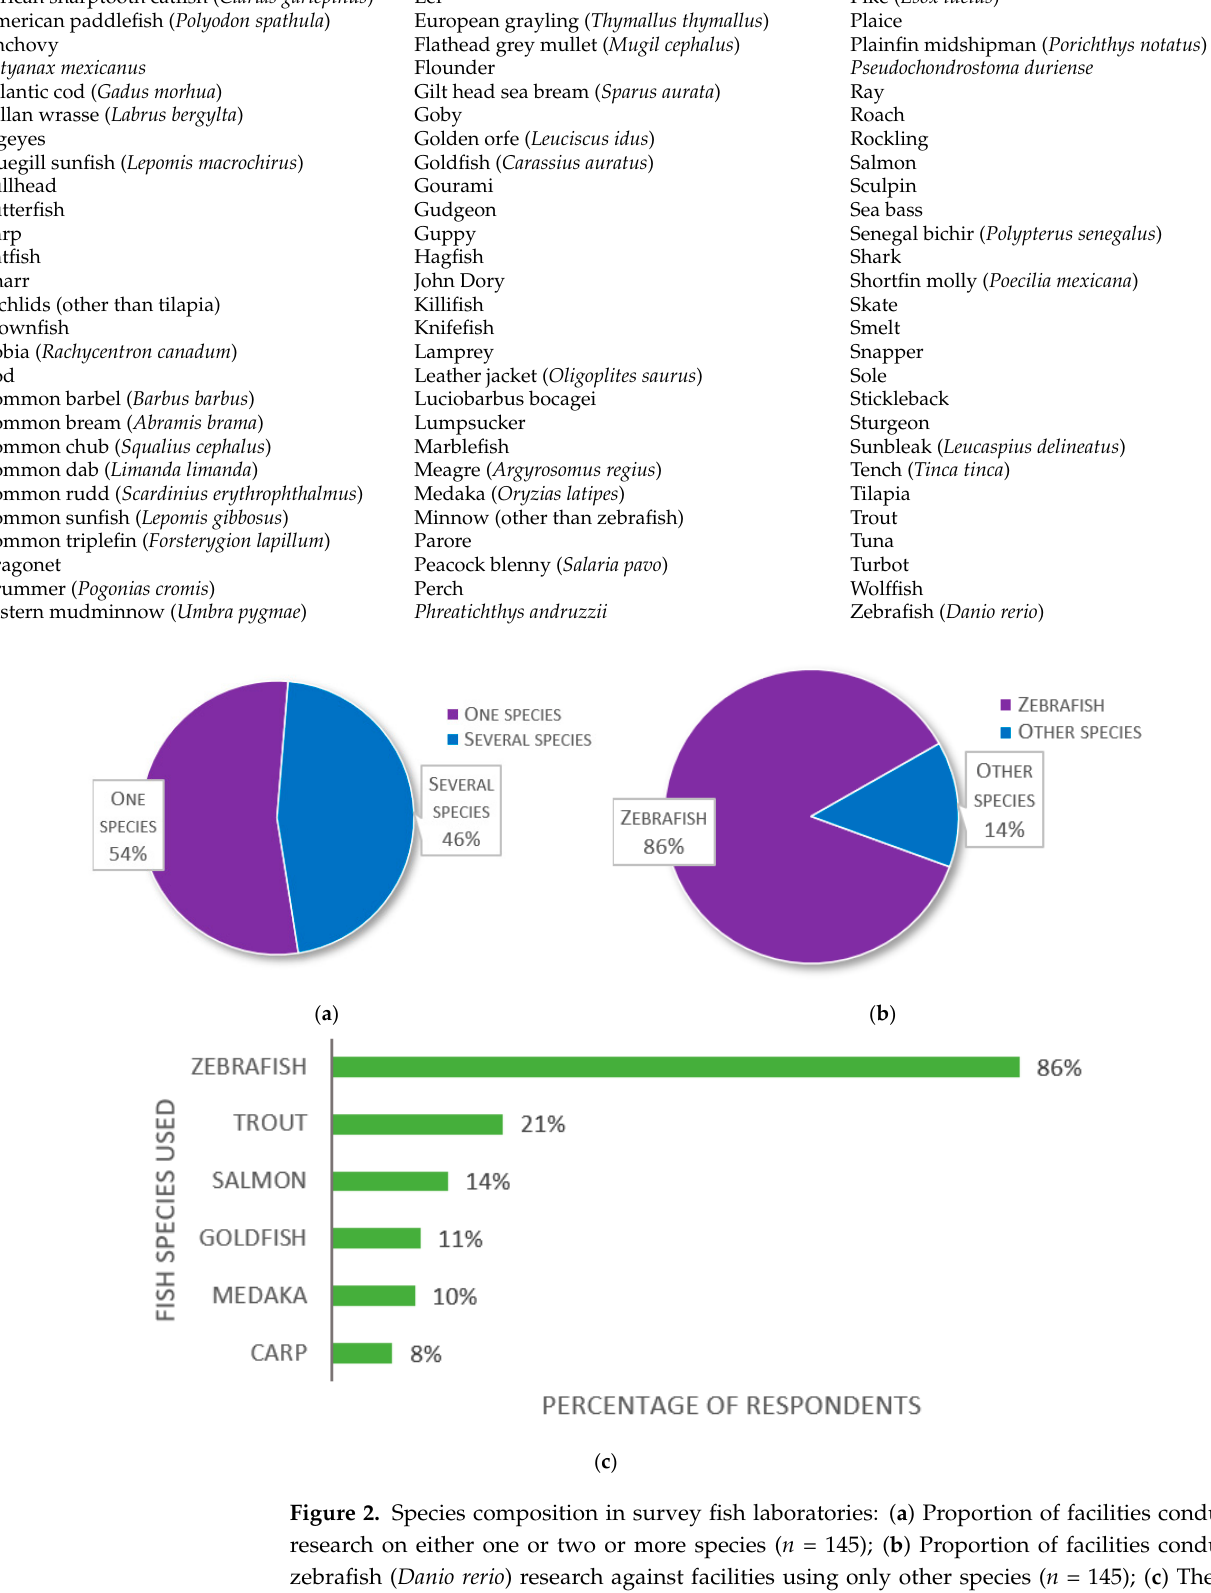
4 of 21 Table 1. List of species and/or groups of fishes used for research by survey participants. African sharptooth catfish ( Clarias